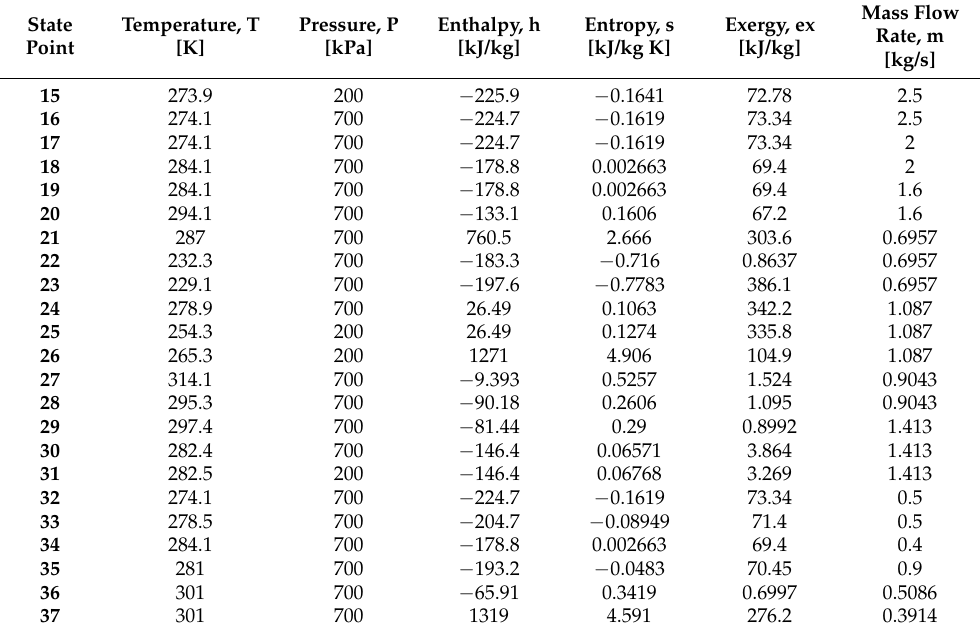
Table 3. State point values of Temperature, Pressure, Enthalpy, Entropy, Exergy and Mass flow rate of Double Effect Vapour Absorption